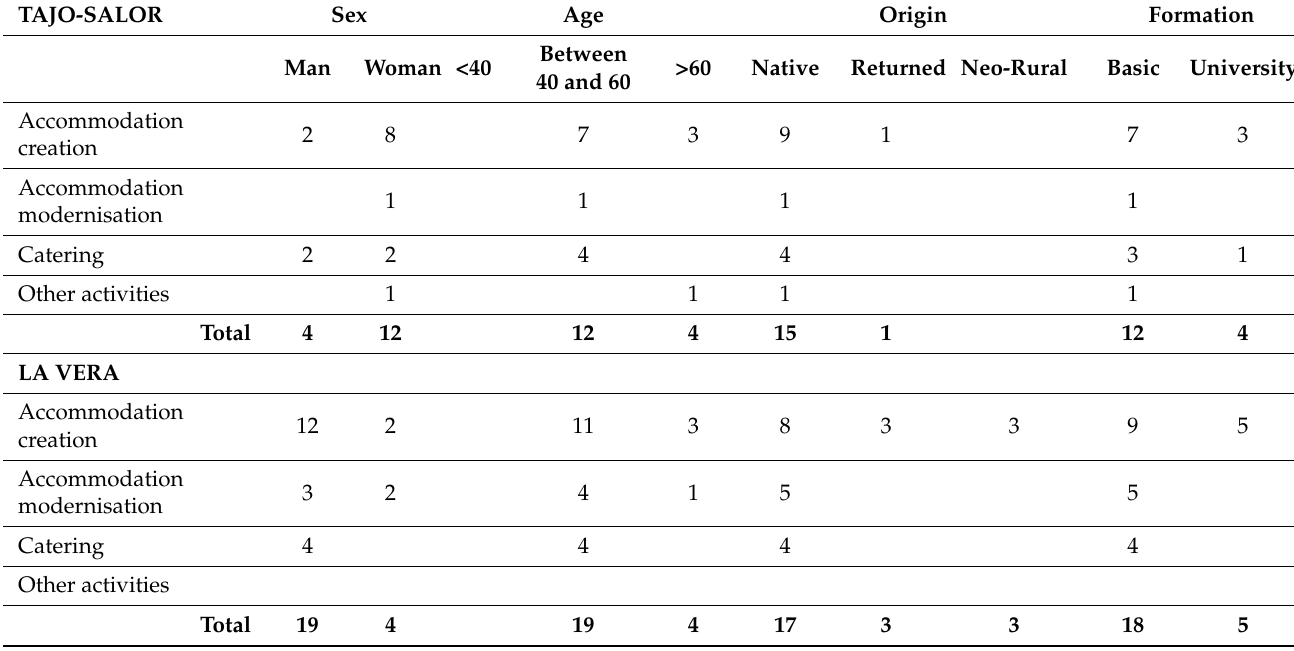
Table 8. Characteristics of the interviewees in the regions of Tajo-Salor and La